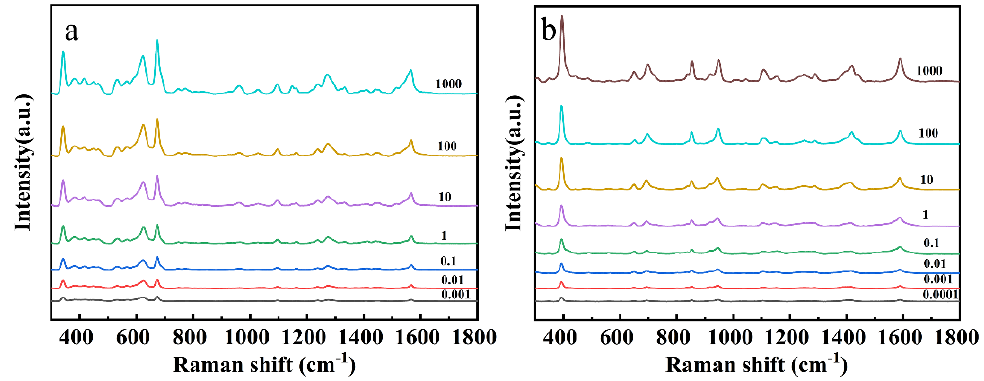
Figure 6. SERS spectra of apple surface samples treated with ( a ) CPF and ( b ) 2.4 − D.